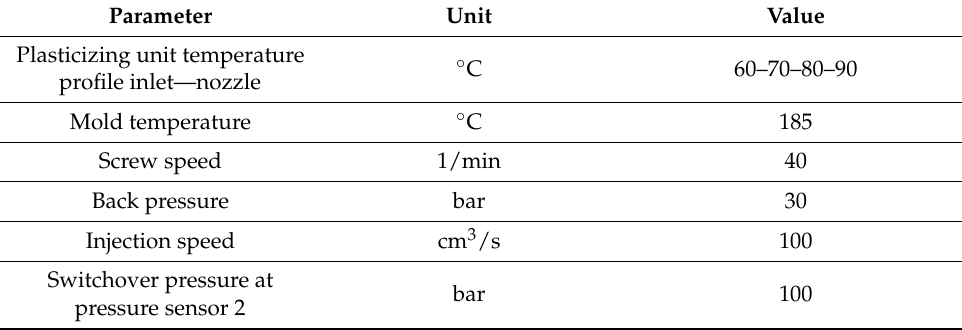
Table 1. Parameters for the injection molding of sample